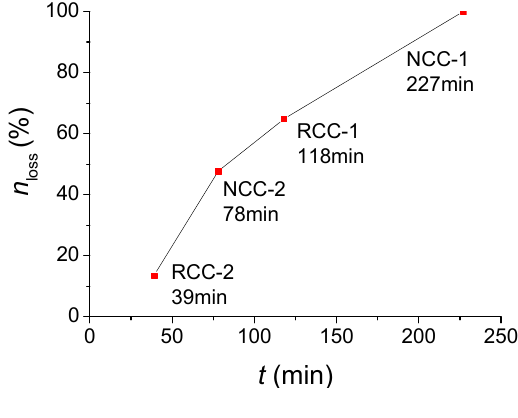
Figure 6. The relationship of loss rate of cubic compressive strength to time.